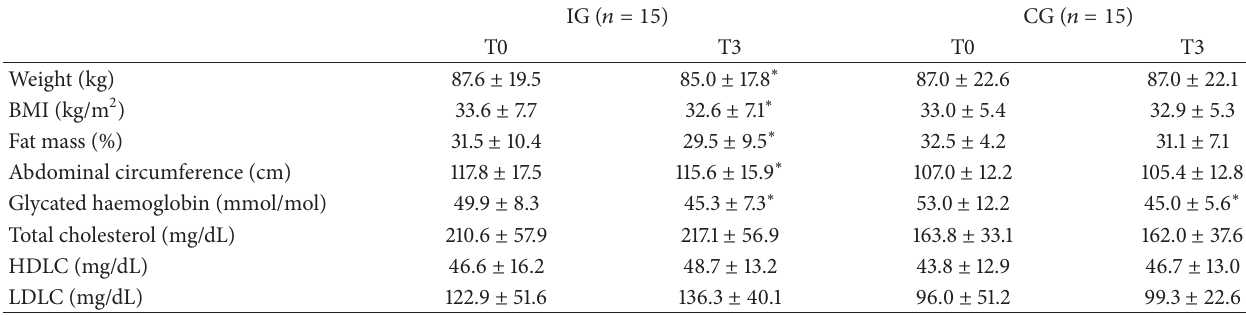
Table 1: Anthropometric measures, lipid profile, and glycated haemoglobin for the intervention group (IG) and the control group (CG) at baseline and after 3-month period.